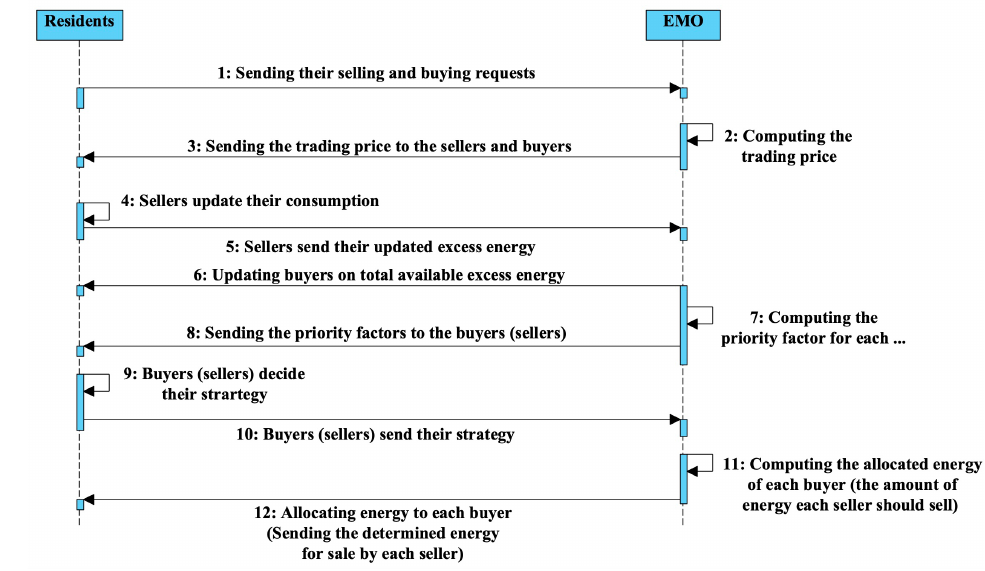
Figure 1. Sequence diagram for the proposed fair local energy trading in FESM